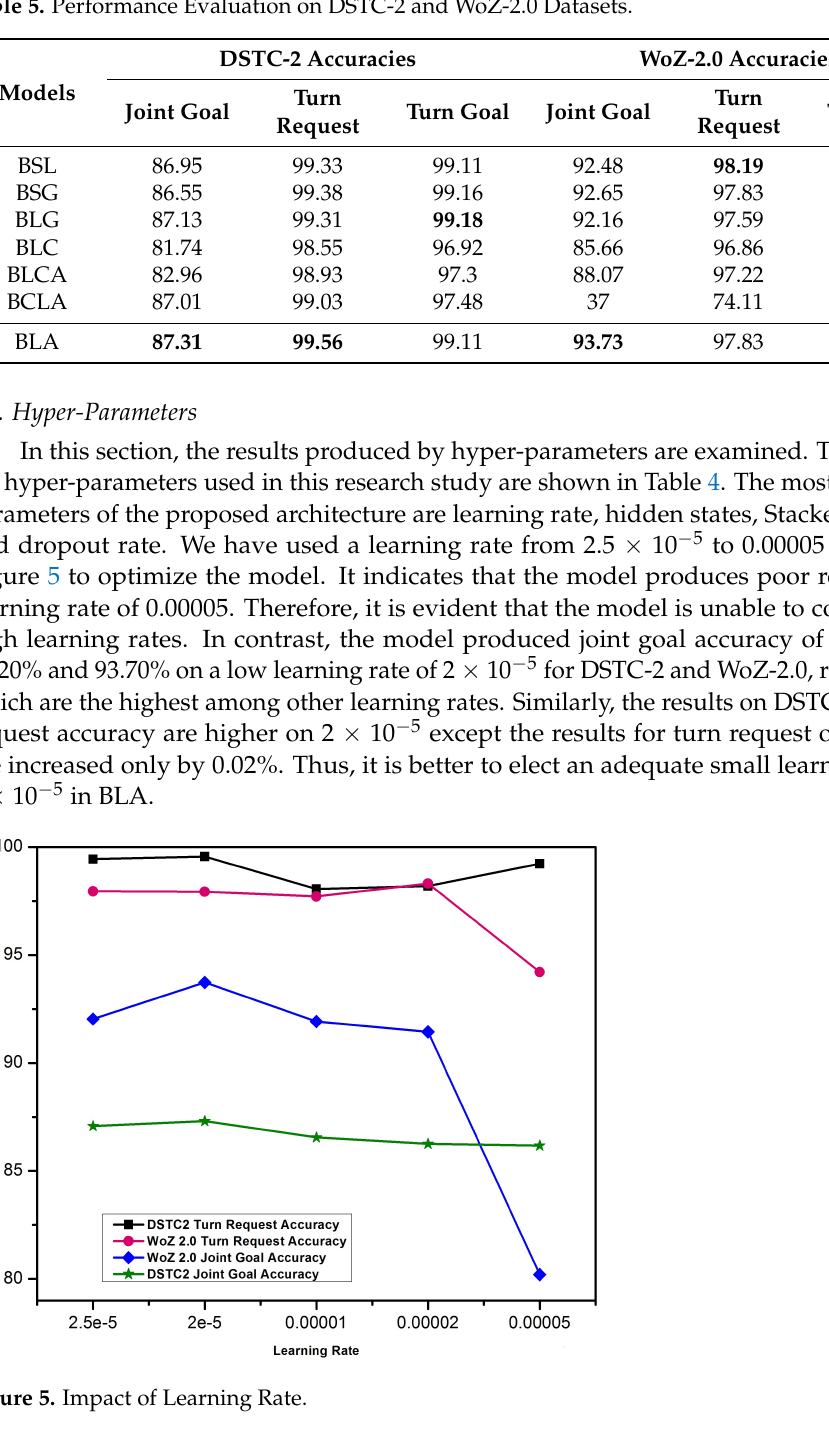
Table 5. Performance Evaluation on DSTC-2 and WoZ-2.0 Datasets.